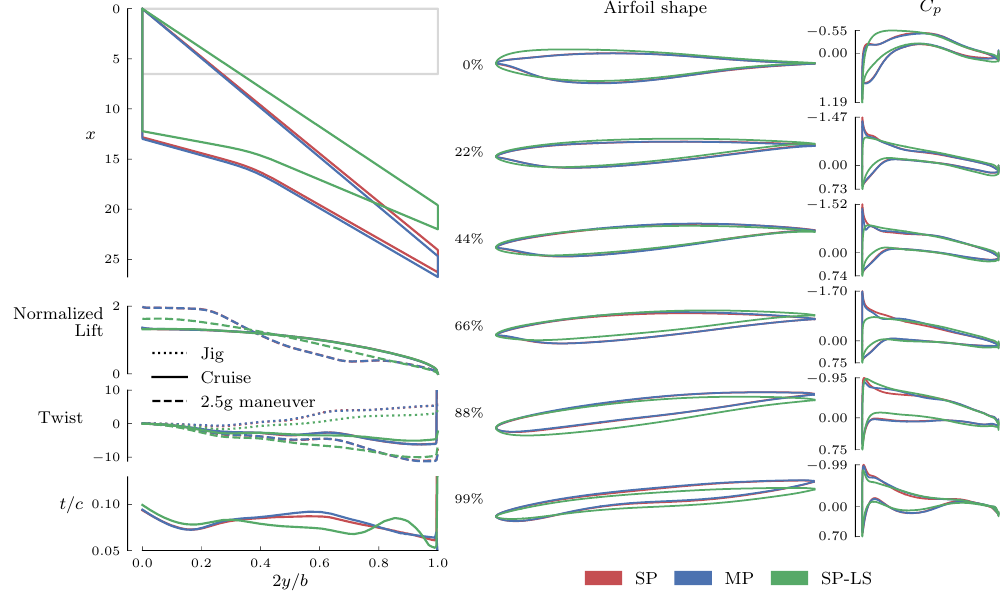
Figure 14. The multipoint design is very similar to the single-point design, but including the low-speed separation constraint elicits striking